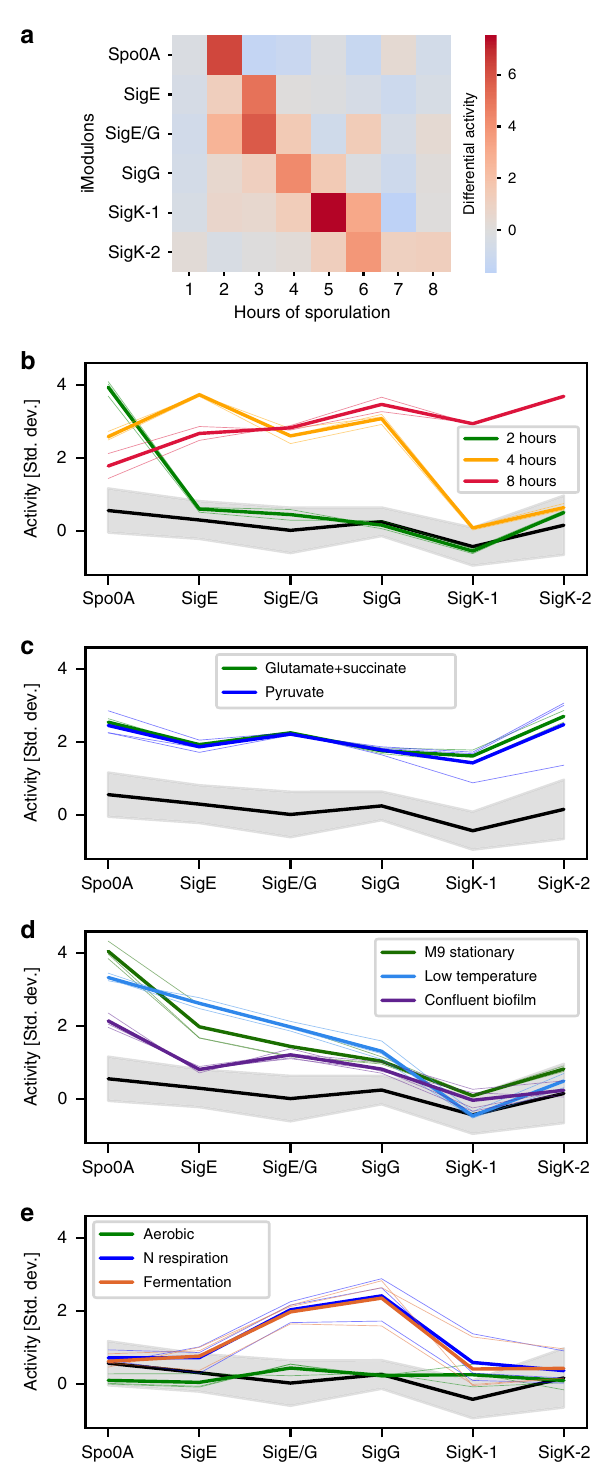
Fig. 3 Six iModulons (named for their enriched regulators) mark progress through sporulation. a Heatmap color indicates the change in iModulon activity over the previous hour. b – e Line plots of the sporulation progression for selected conditions, with thick lines indicating mean activity and thin lines indicating individual samples. Activity levels were divided by the standard deviation. The black line surrounded by a shaded gray region is the average of all conditions not shown in any plot ± standard deviation ( n = 200 samples). b Three time points of sporulation, showing Spo0A activation at sporulation onset (2 h, green), cumulative expression up to the fourth step (SigG) for an intermediate time point (4 h, orange), and expression of all stages at 8 h (red). c Minimal media supplemented with these carbon sources leads to expression of all sporulation